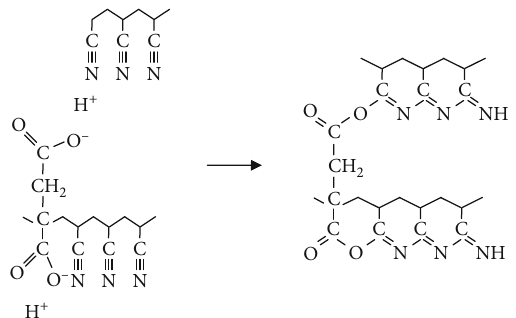
Figure 2: Cyclization in poly(AN- co -IA) initiated through an ionic mechanism